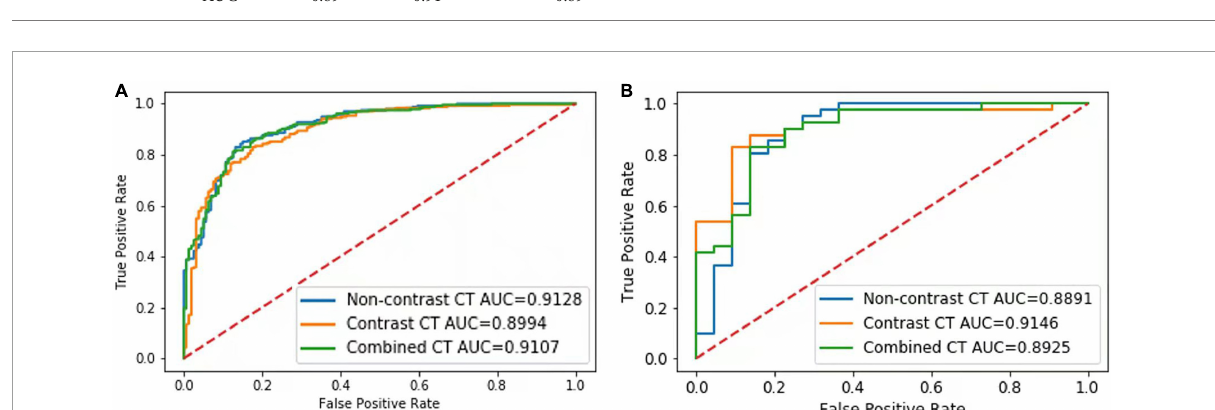
FIGURE2 Results of the receiver-operating characteristic (ROC) curve analysis. The ROC curves of the NCCT, CECT, and combined models for identification of invasive adenocarcinoma (IAC) in the validation set (A) and external testing set (B) are shown.